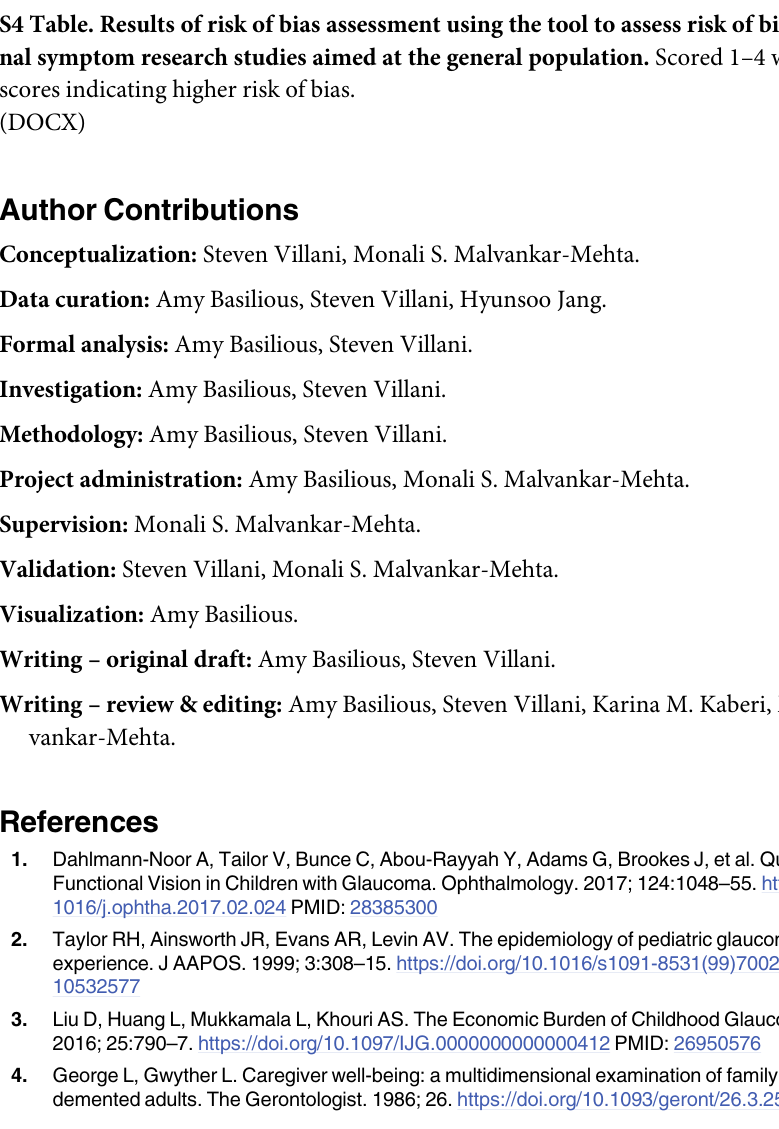
S1 Table. PRISMA guidelines checklist. S2 Table. Search strategies for each database and number of results until October 10, 2021. S3 Table. Results of risk of bias assessment using the risk of bias instrument for cross-sec- tional surveys of attitudes and practices. Scored 1–4 with higher scores indicating higher risk of bias. S4 Table. Results of risk of bias assessment using the tool to assess risk of bias in longitudi- nal symptom research studies aimed at the general population. Scored 1–4 with higher scores indicating higher risk of